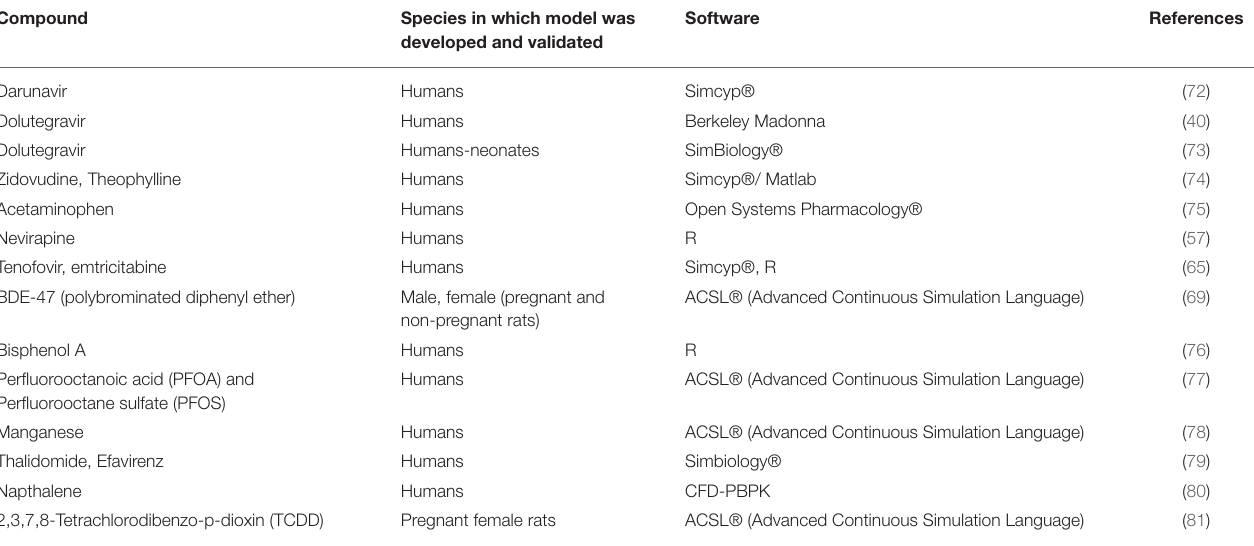
TABLE 7 | List of published p-PBPK models to predict fetal exposure.